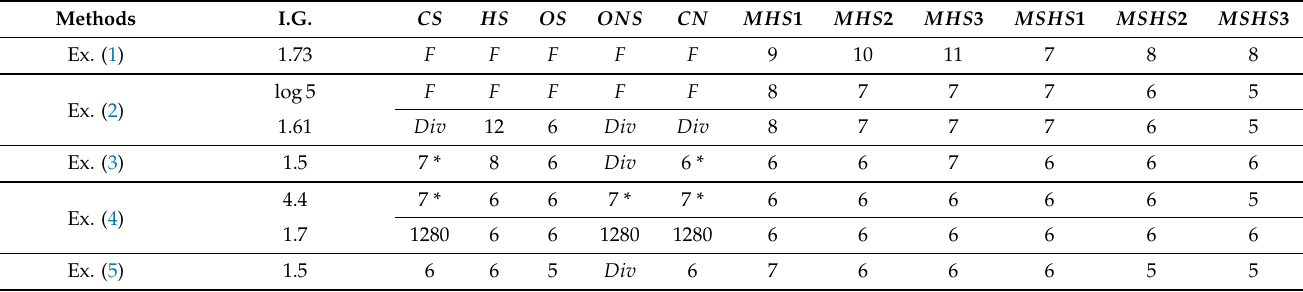
Table 2. Contrast of distinct iterative methods based on number of iterations. * stands for convergence to undesired root.